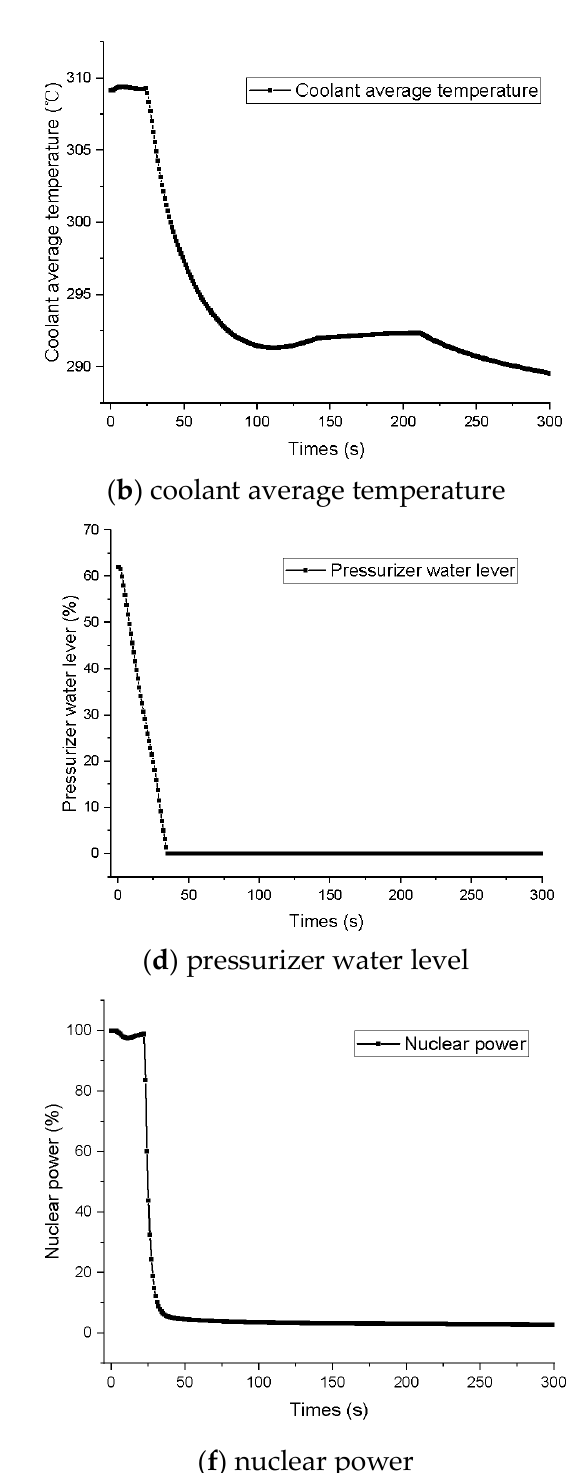
Figure 6. Operating trend of normal operation.